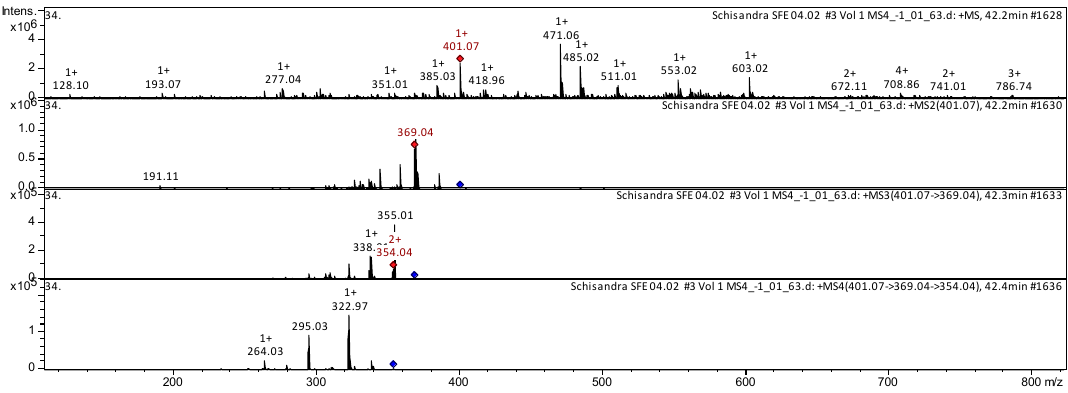
Figure 3. Collision-induced dissociation (CID) spectrum of the schisandrin B (gomisin N, isokadsuranin) from S. chinensis , m/z 401.07.